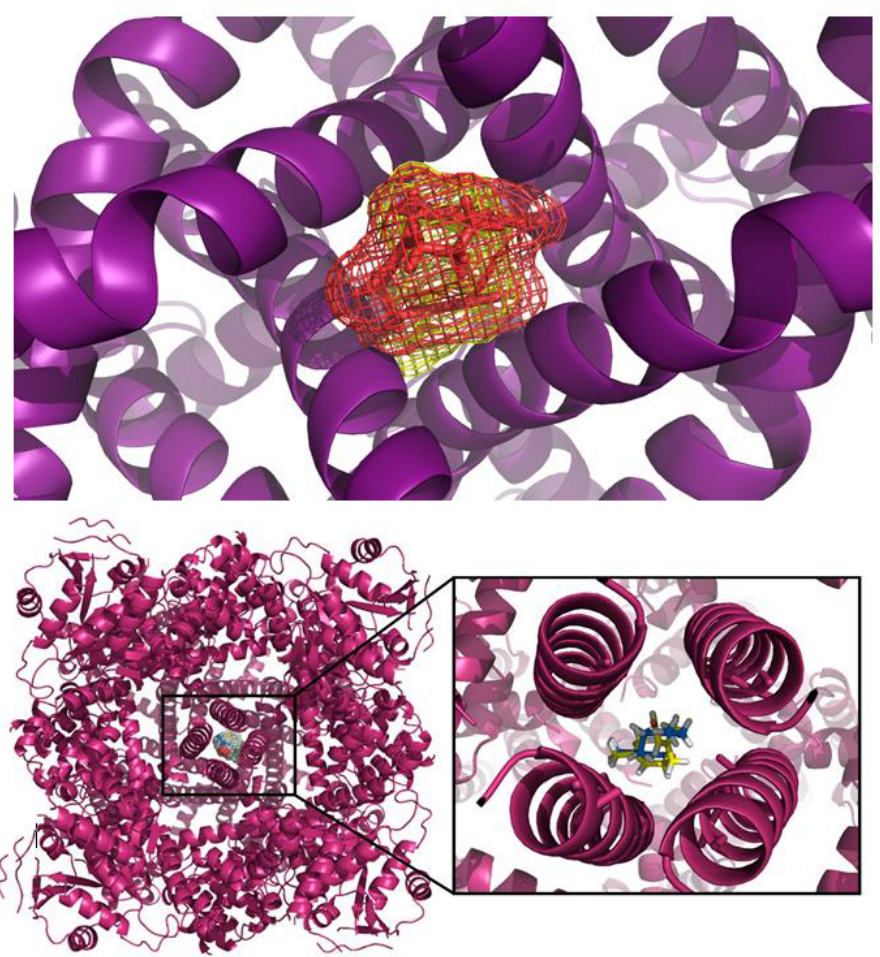
Figure 8: Overlay of the electronic cloud of the geranial (yellow) with capsazepine (red), showing spatial similarities and compatibility in the same site, which supports the action of the geranial resembling that of capsazepine. Neral (blue sticks) and geranial (yellow sticks) isomers interacting specifically with the TRPM8 channel, in the central region, rich in alpha-helix